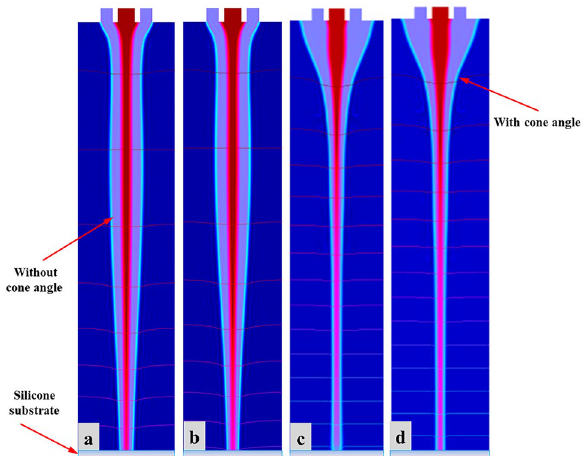
Figure 10. The specific morphologies of the simulated CE-Jet at different dynamic viscosity of outer solution ( a ) 3.5 Pa * s ( b ) 3.0 Pa * s ( c ) 2.5 Pa * s and ( d ) 2.0 Pa * s.